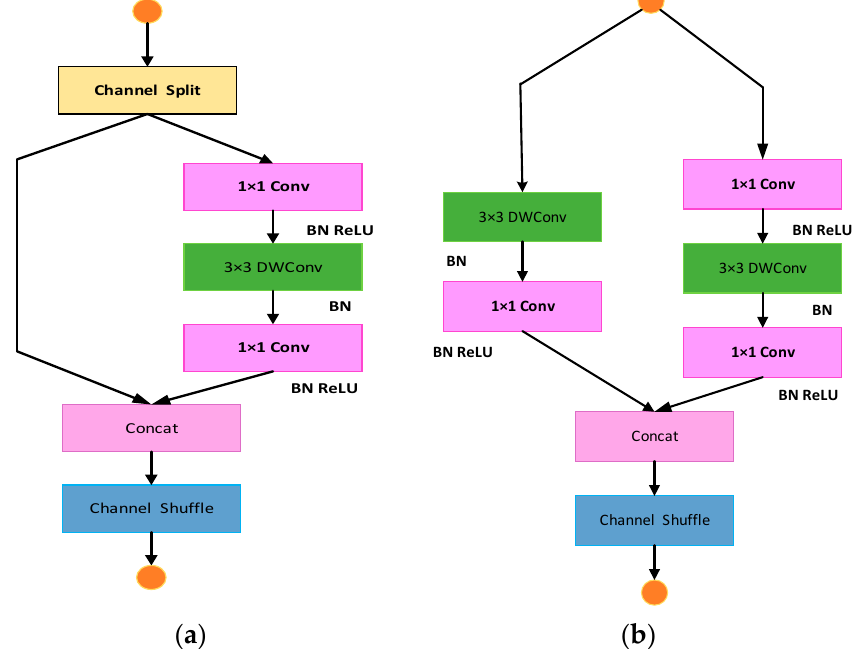
Figure 3. ShuffleNet V2 architecture diagram. ( a ) the basic ShuffleNet V2 unit; ( b ) ShuffleNet V2 unit for spatial downsampling (2×)